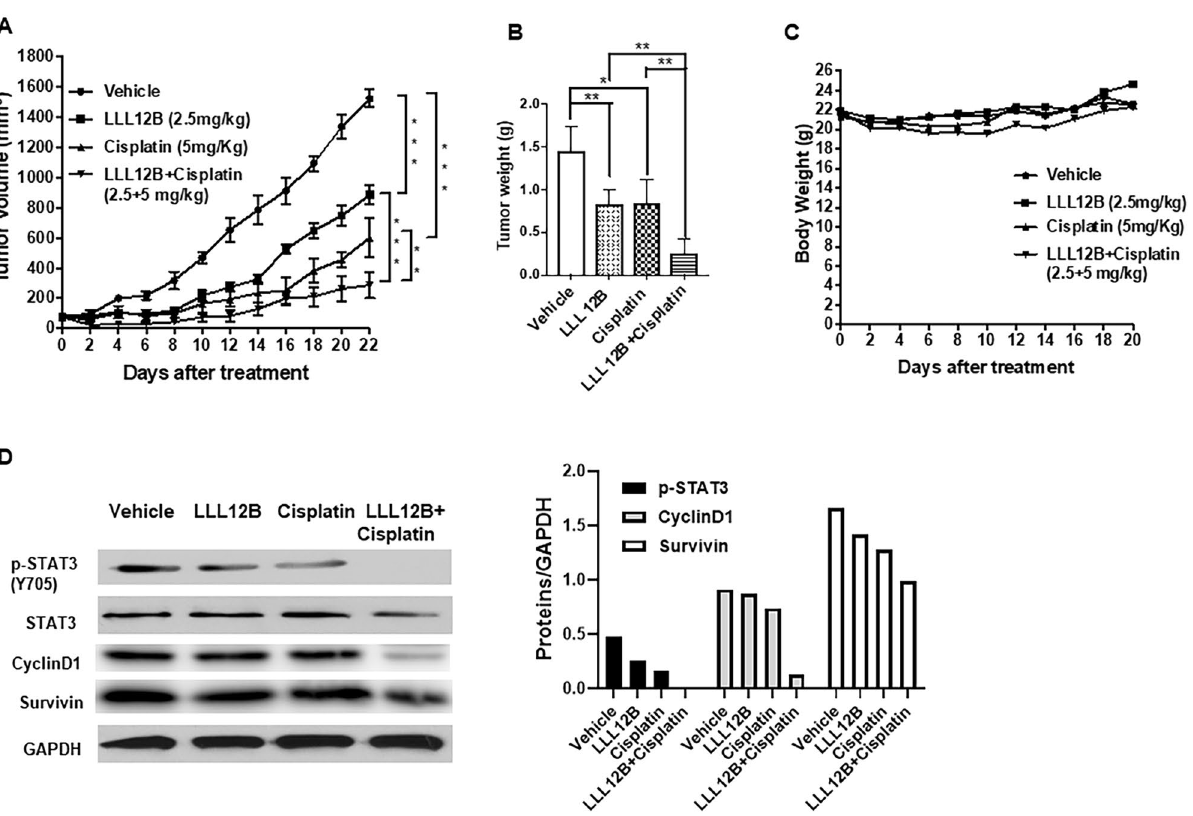
Figure 9. LLL12B and cisplatin combination suppressed tumor growth in D283 medulloblastoma xenografts. ( A ) Tumor volumes. ( B ) Tumor weights. ( C ) Body weight. ( D ) Western blots to analyze protein expression in the representative tumor samples. Expression levels of p-STAT3(Y705), STAT3, CyclinD1, Survivin, and GAPDH. D283 medulloblastoma cells (1 × 10 7 cells/tumor) were implanted subcutaneously into the flank region of 4 to 5 week-old female athymic nude mice. Mice were randomized into four groups (5 mice for each group) and treated with LLL12B (2.5 mg/kg, oral gavage, once daily) and/or cisplatin (5 mg/kg, intraperitoneal injection, once every 4 days) or vehicle